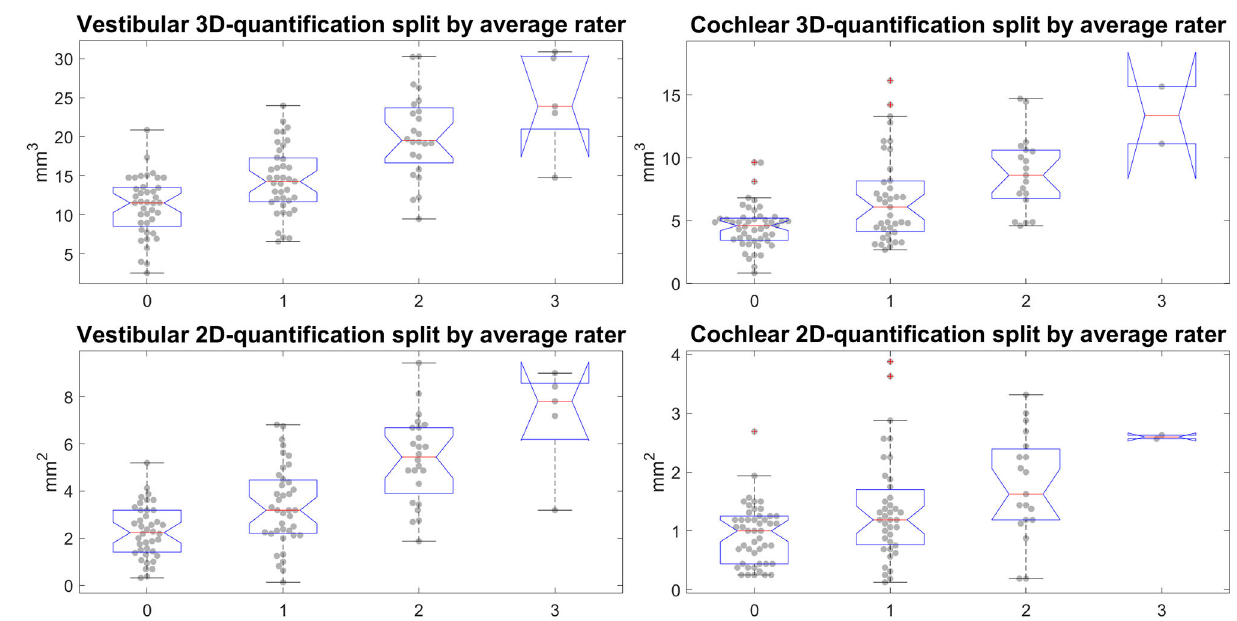
Frontiers in Neurology |